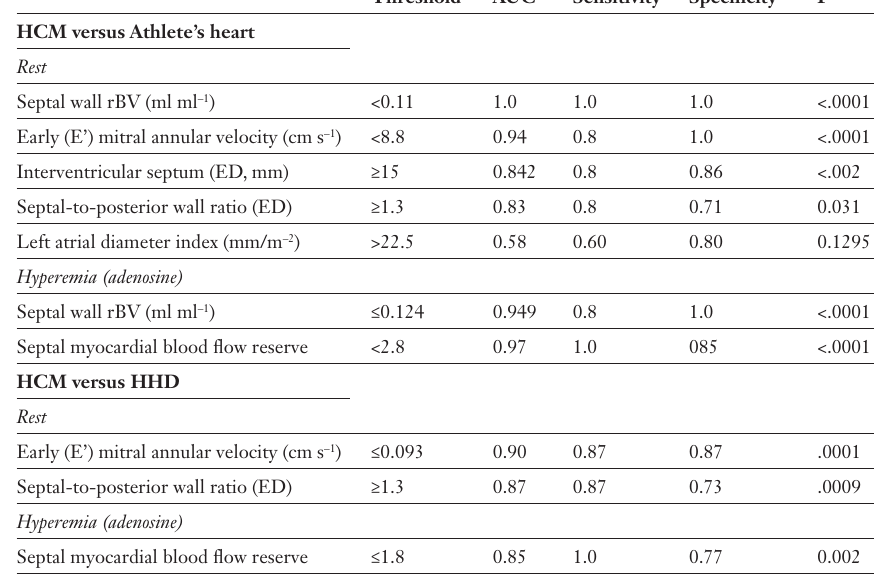
Individual data of relative myocardial blood volume (rBV) obtained during rest- ing conditions and at the septal wall in patients with hyper- trophic cardiomyopa- thy (HCM; n = 15) with left ventricular hyper- trophy (LVH), in semi-professional triathletes with LVH (n = 15), in hyperten- sive patients with LVH (n = 15), and in healthy, sedentary in- dividuals without LVH (n = 15). The squared symbols with error lines indicate mean values ± standard de- viation.